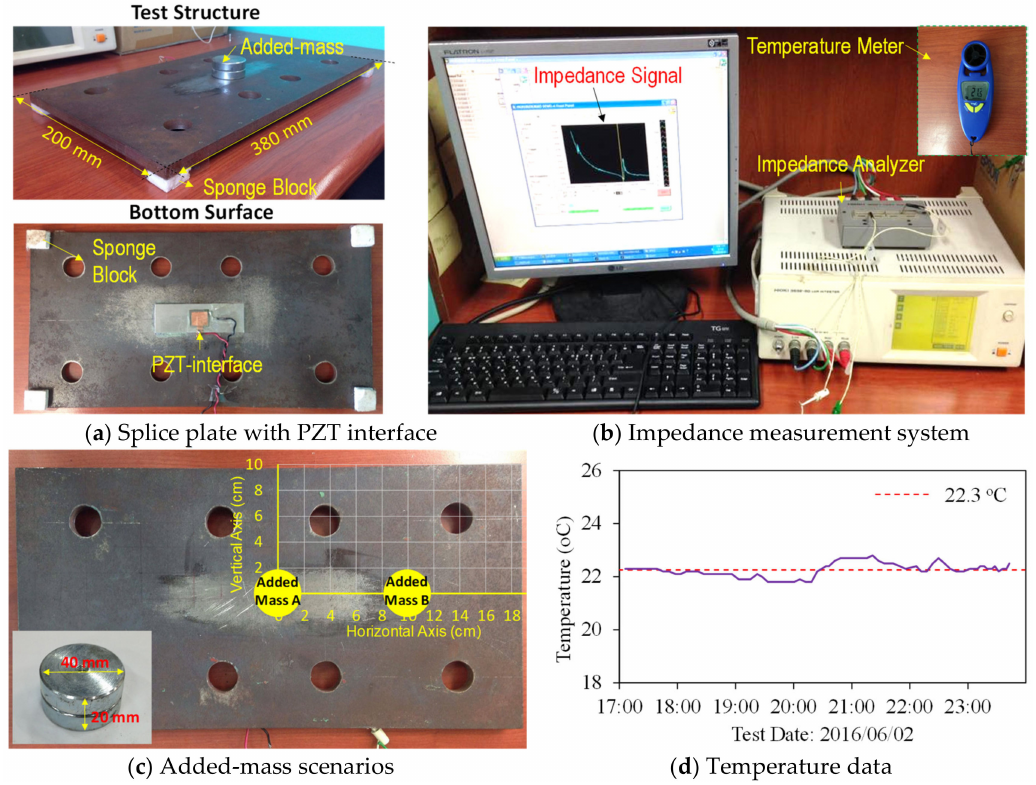
Figure 10. Test-setup for analyzing sensing region of PZT interface on a connection splice